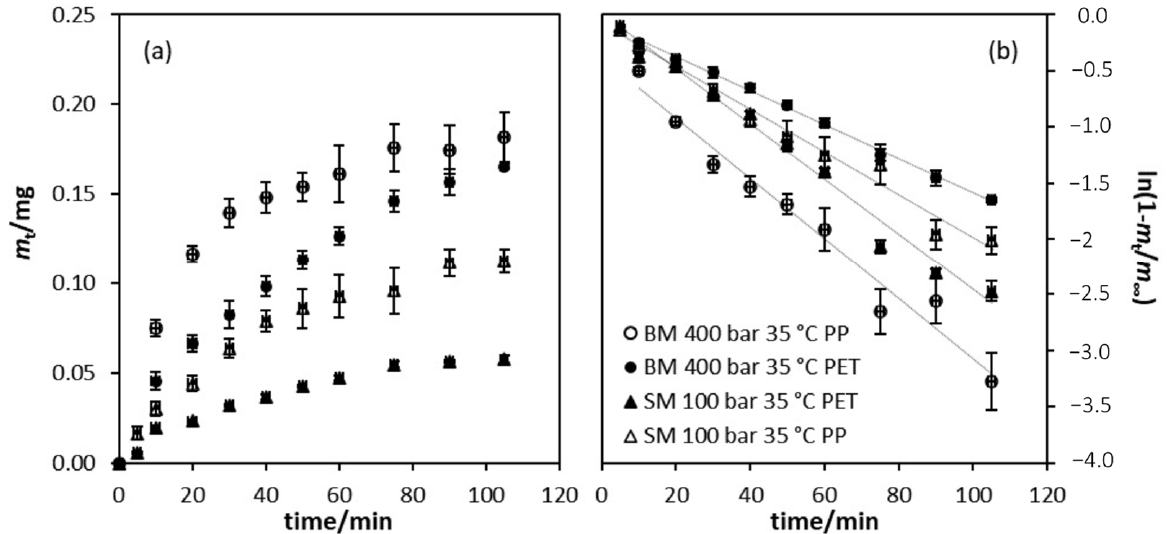
Figure 4. Solute release into the 50% v/v ethanol in water food simulant ( a ) and first order kinetics plot of solute release ( b ).